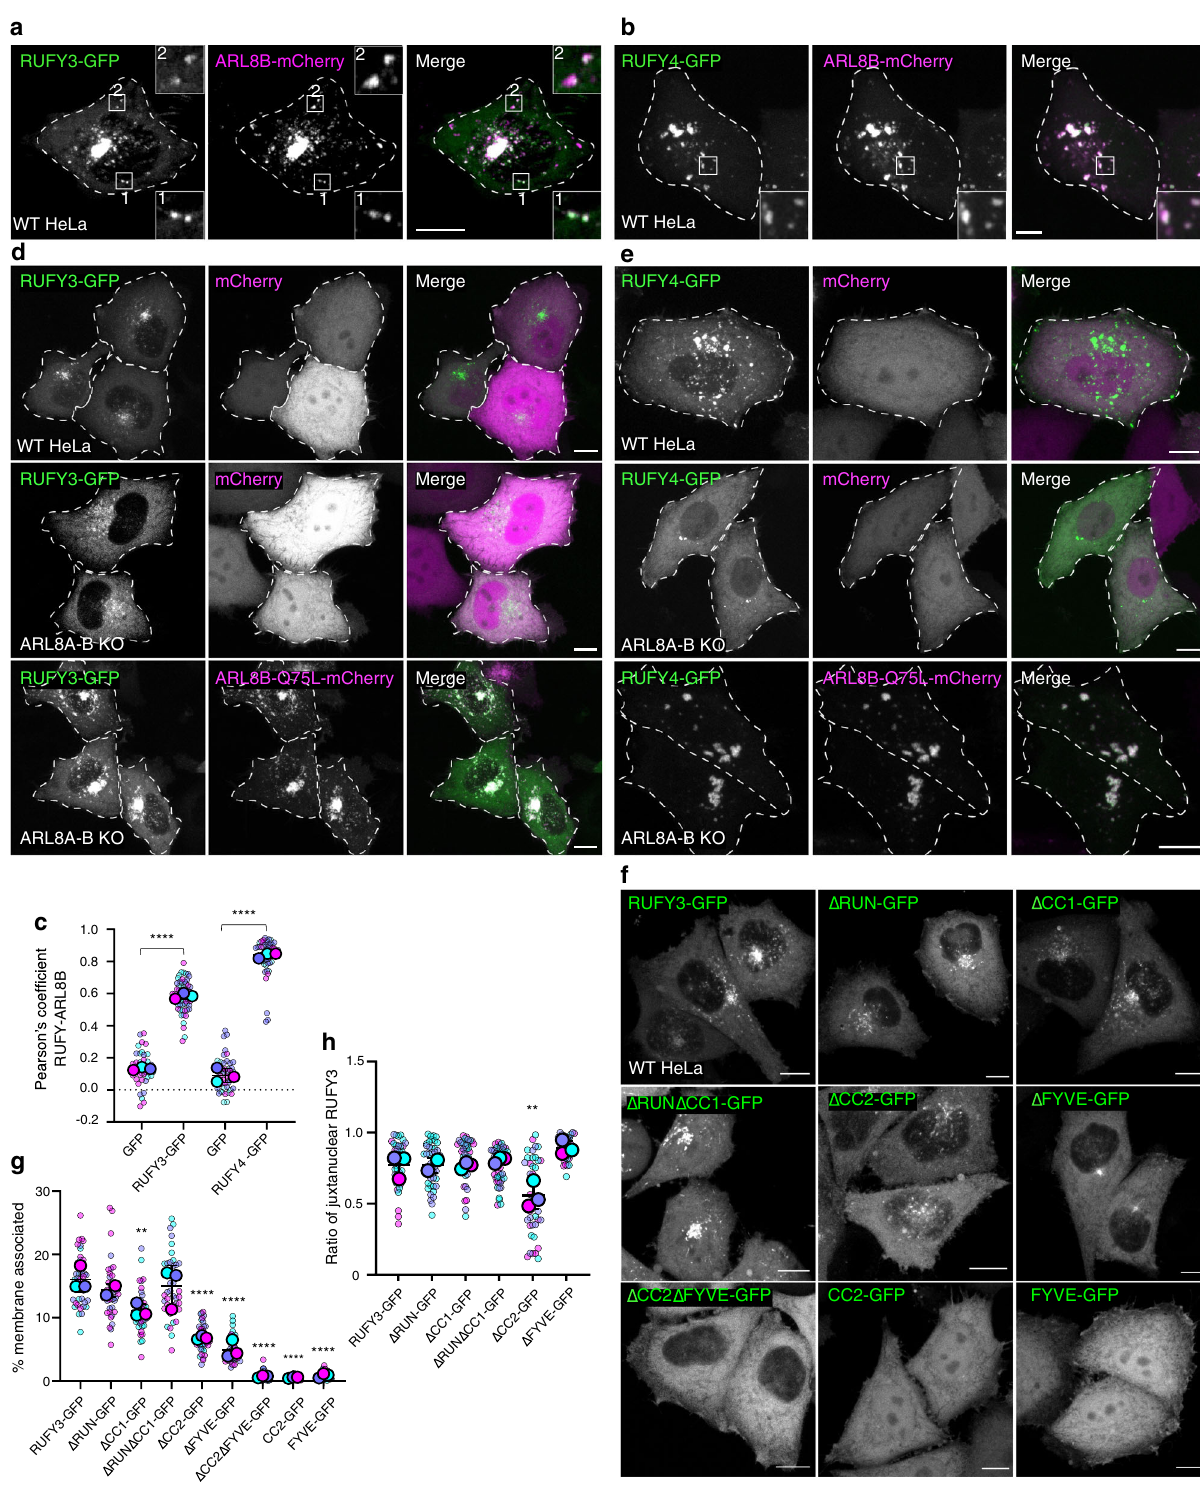
(Fig. 6e, g), and shifted the balance of the remaining LAMP1-RFP tracks to the retrograde direction (Fig. 6e, f) (for evidence of RUFY-LAMP1 co-movement, see also Supplementary Movie